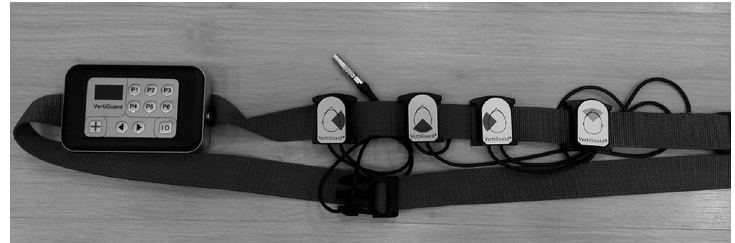
Figure 2 Vertiguard TM : main unit and vibrotactile